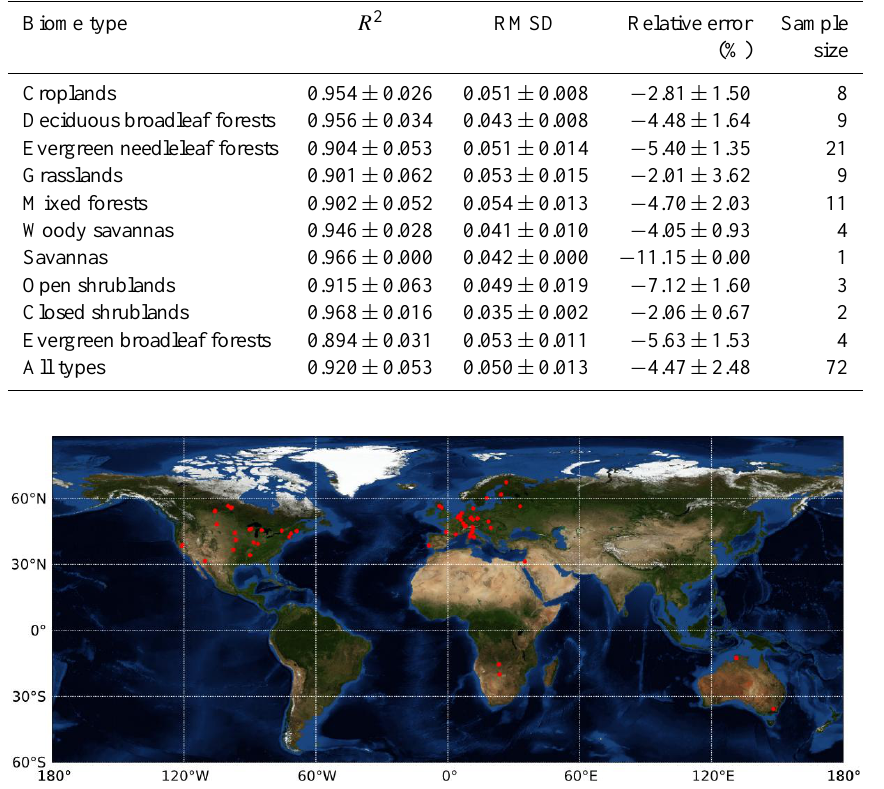
Table 2. Statistical results for the comparisons between midday EF and daytime EF over different biome types.